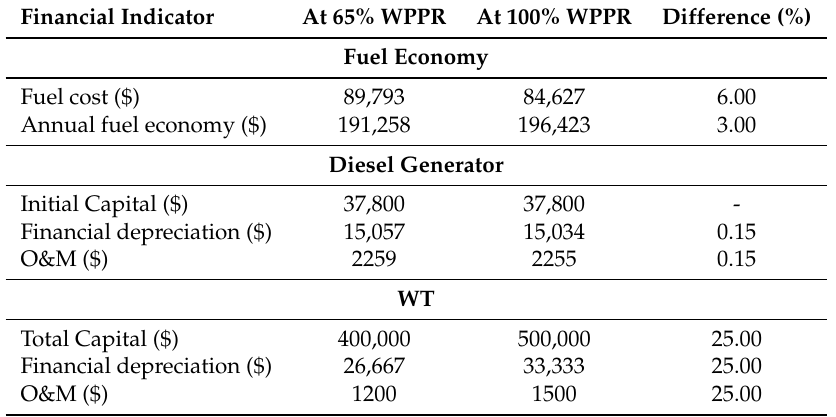
Table 9. Influence of WPPR on fuel economy, diesel generator and wind turbine (WT)